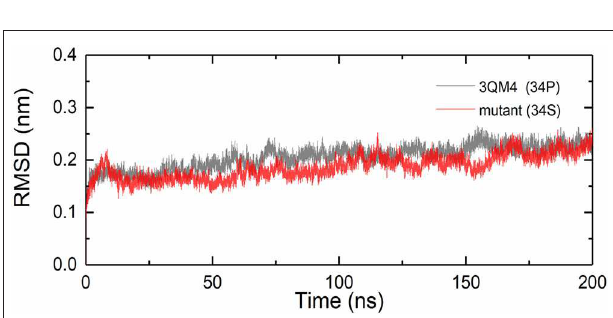
FIGURE 4 | Root mean square deviations (RMSDs) for the native (black) and mutant (red) of CYP2D6.